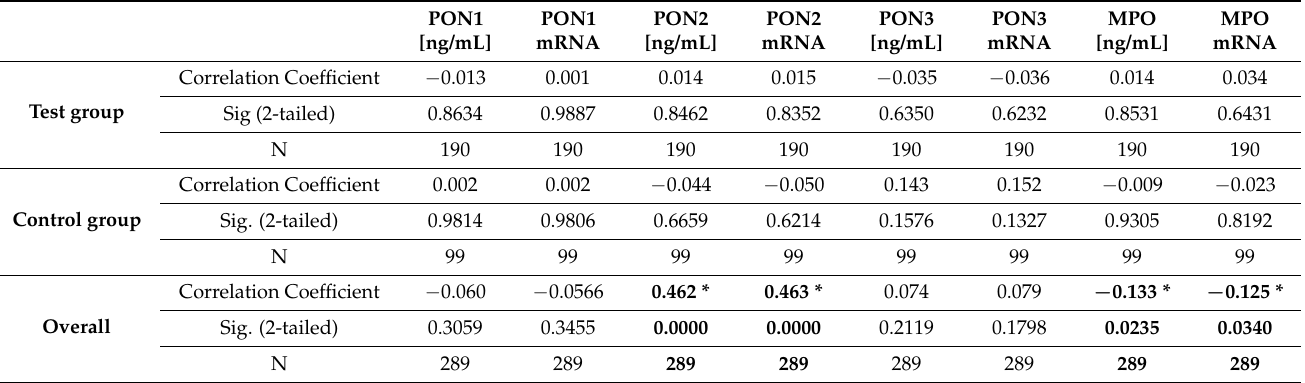
Table 5. Spearman’s correlations of gene expression with age by study group. * indicates statistical